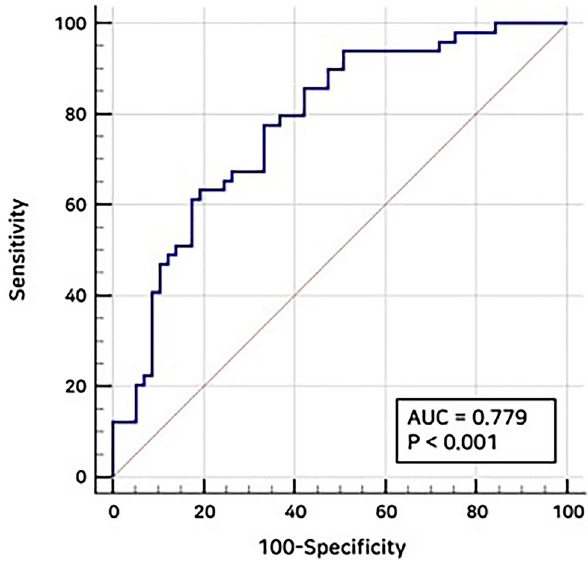
Figure 3. Receiver operating characteristic curve of temporalis muscle thickness (TMT) on CT for the detection of tumor recurrence. The receiver operating characteristic curve of TMT on CT shows a fair accuracy of predicting tumor recurrence with an area under the curve value of